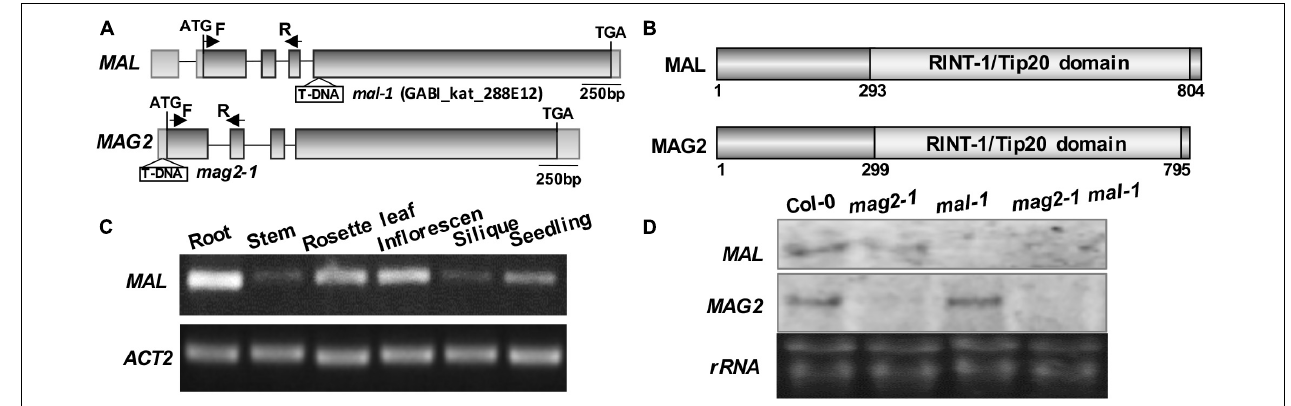
FIGURE 1 | Structural diagram of MAL and T-DNA insertion mutant. (A) MAG2 and MAL gene structures and T-DNA insertion sites in the mutants. The arrows indicate the position of real-time (RT)-PCR primers. (B) MAL and MAG2 protein structures and conserved domains. (C) RT-PCR determination of the tissue expression pattern of MAL . (D) Northern blot detection of the expression levels of MAL and MAG2